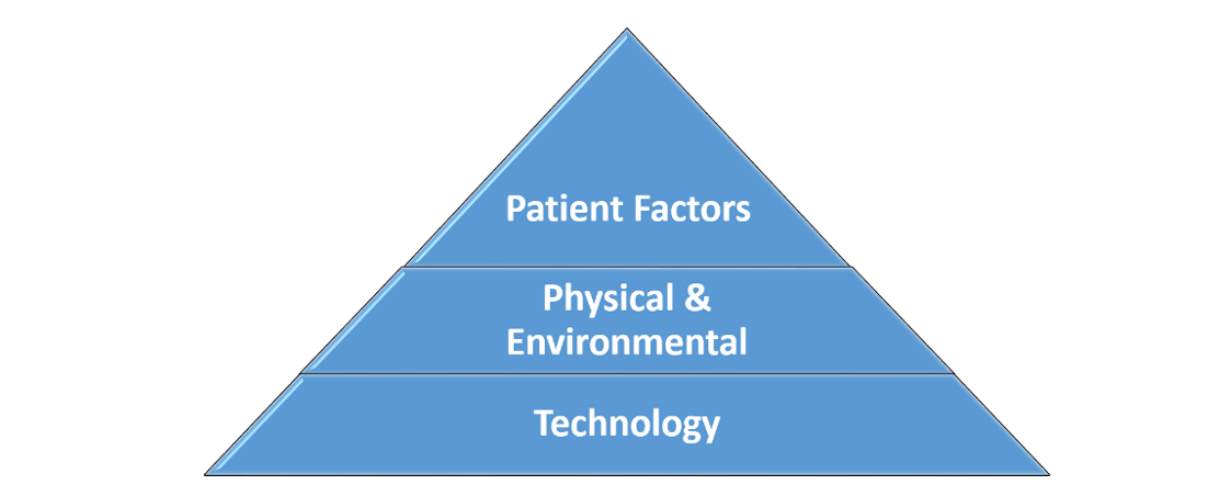
Figure 3. Fundamental assessment prioritization